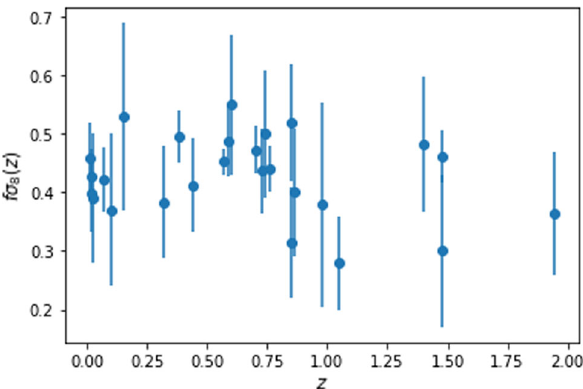
Fig. 2 The [ f σ 8 ] ( z ) data displayed in Table